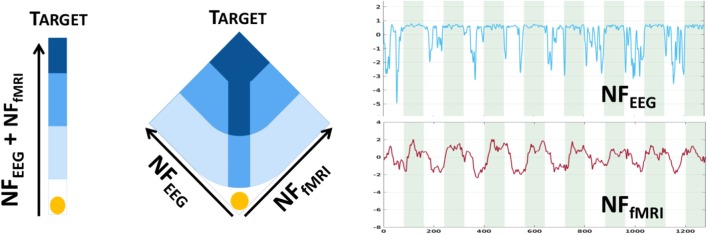
Bi-modal neurofeedback metaphors (1D on the left, 2D on the middle) displayed during sessions (Perronnet et al., 2018). 1D: the ball's position represents the sum of ye and yf. 2D: the left axis represents the ye, and the right axis represents the yf scores. The two plots on the right show NF scores from EEG and from fMRI; green areas are task and white areas are rest. The goal is to bring the ball into the dark blue area.